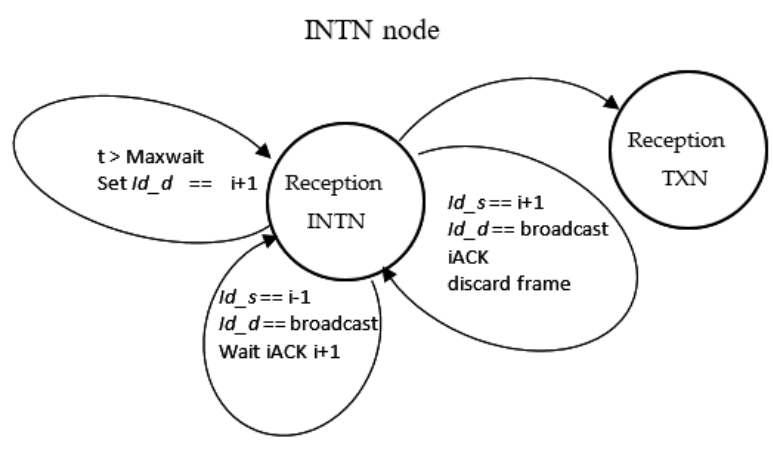
Figure 10. INTN node state diagram.